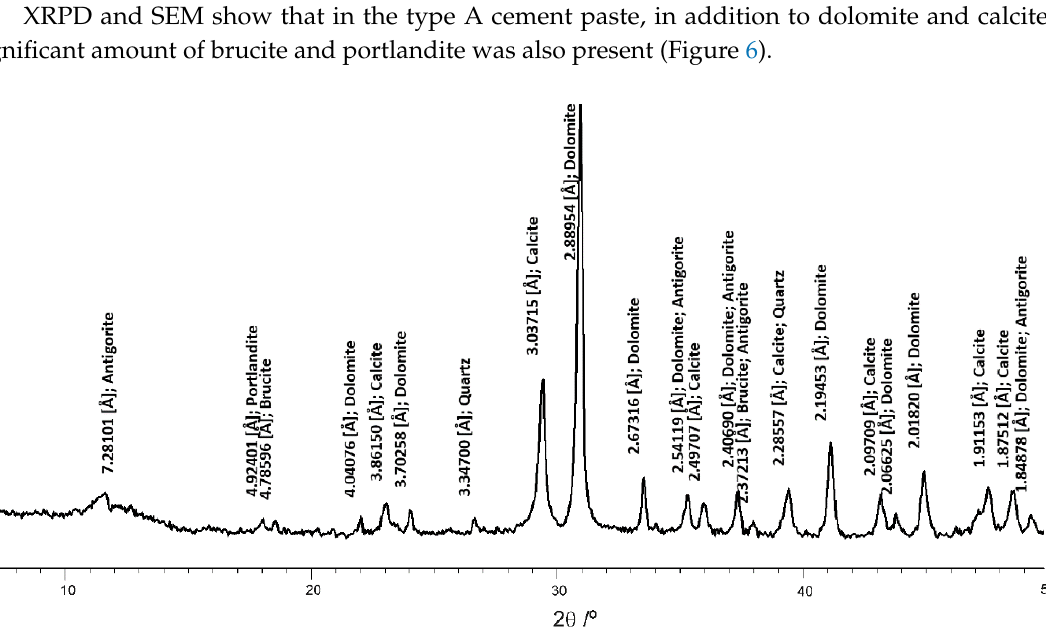
Figure 6. XRPD pattern of the cement paste of type A concrete.